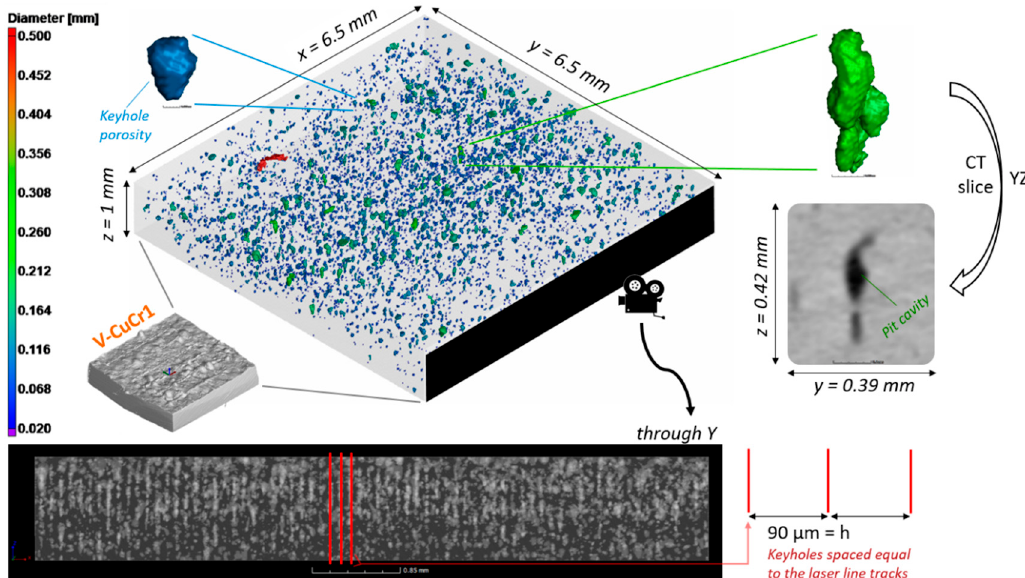
Figure 5. Overview of the porosity distribution in the V-CuCr1 sample, comprising a color-coded 3D view of the porosities, zoomed inserts of two exemplary pores, and a view along the Y direction of the sample to highlight the distribution of the defects following the LPBF hatch spacing of 90 µm.